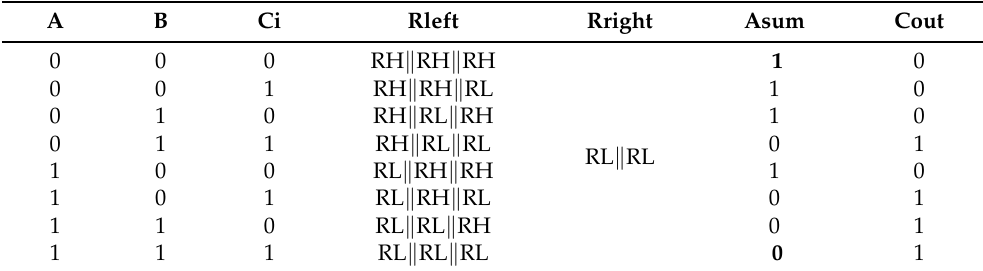
Table 2. Truth table of the proposed 1-bit Approximate Full